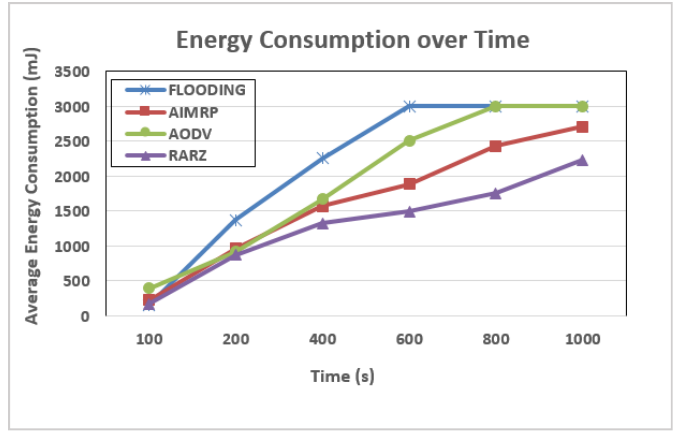
Figure 7. Average energy consumption over time.